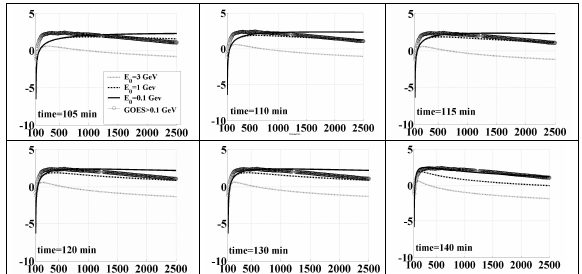
Predicted FEP integral fluxes for E k ≥ E o = 0 . 1 GeV , E k ≥ E o = 1 GeV , E k ≥ E o = 3 GeV . The forecasted integral